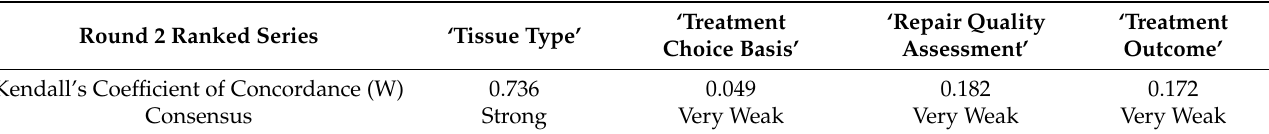
Table 5. A summary of the consensus results for the ranked series in round 2. Only the ‘Tissue type’ ranked series showed strong consensus.